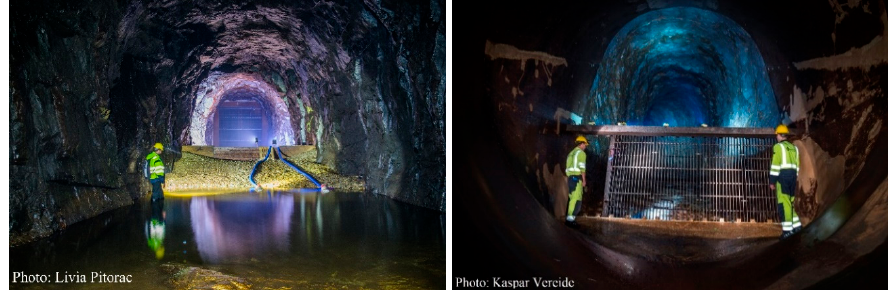
Figure 5. Rock trap and trash rack: view from upstream ( left ) and view from downstream ( right ).